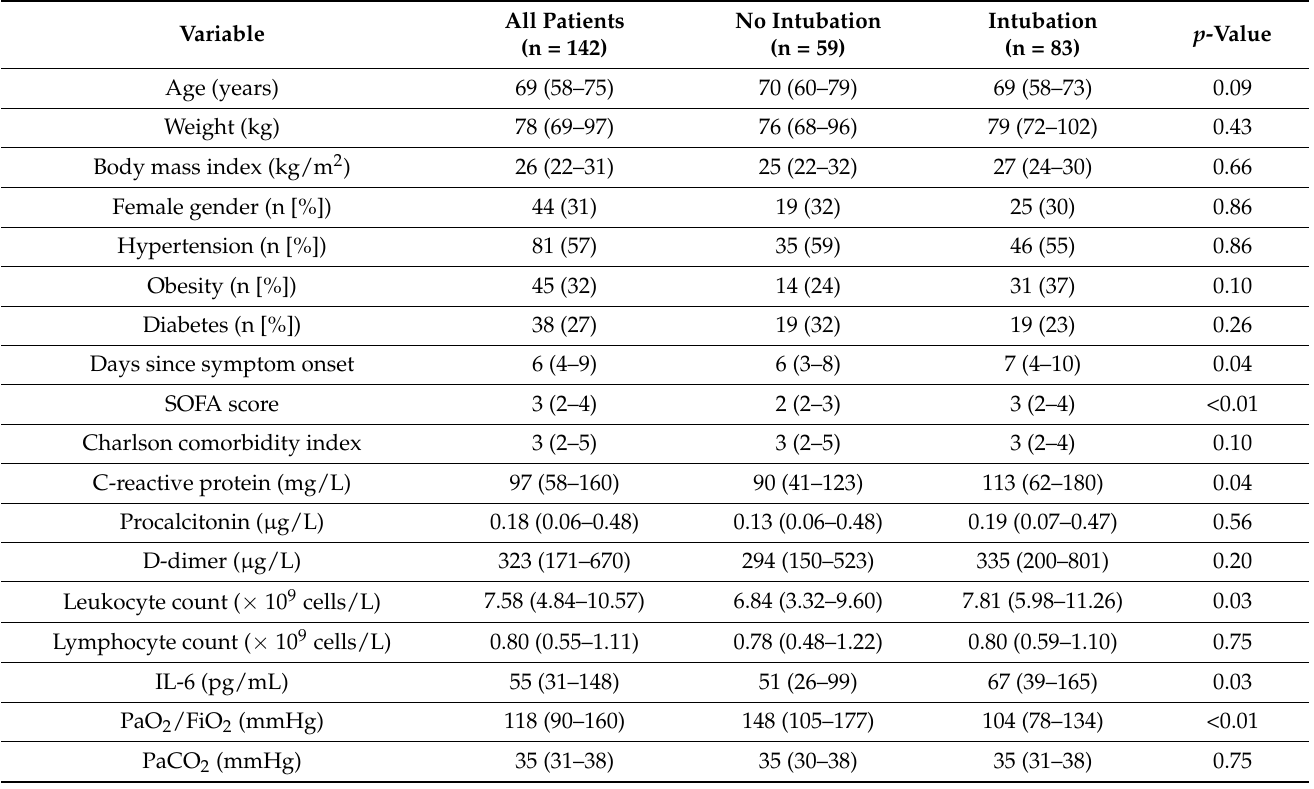
Table 1. Patients’ baseline